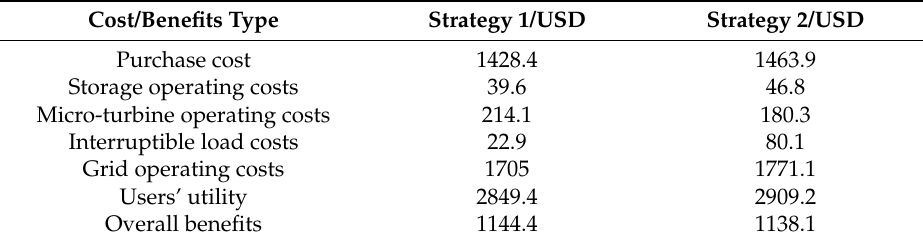
Table 3. Cost and benefit of Strategy 1 and Strategy 2.